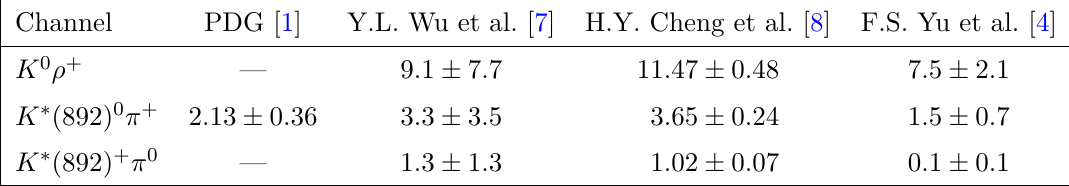
decays to a vector and pseudoscalar meson, showing the measured BFs Table 1 . Summary of D + s and theoretical predictions from various models ( × 10 − 3